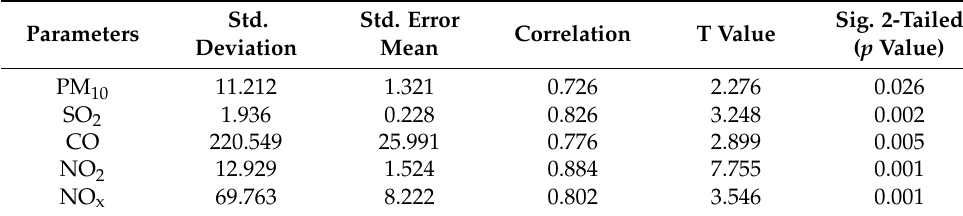
Table 1. Statistical values of